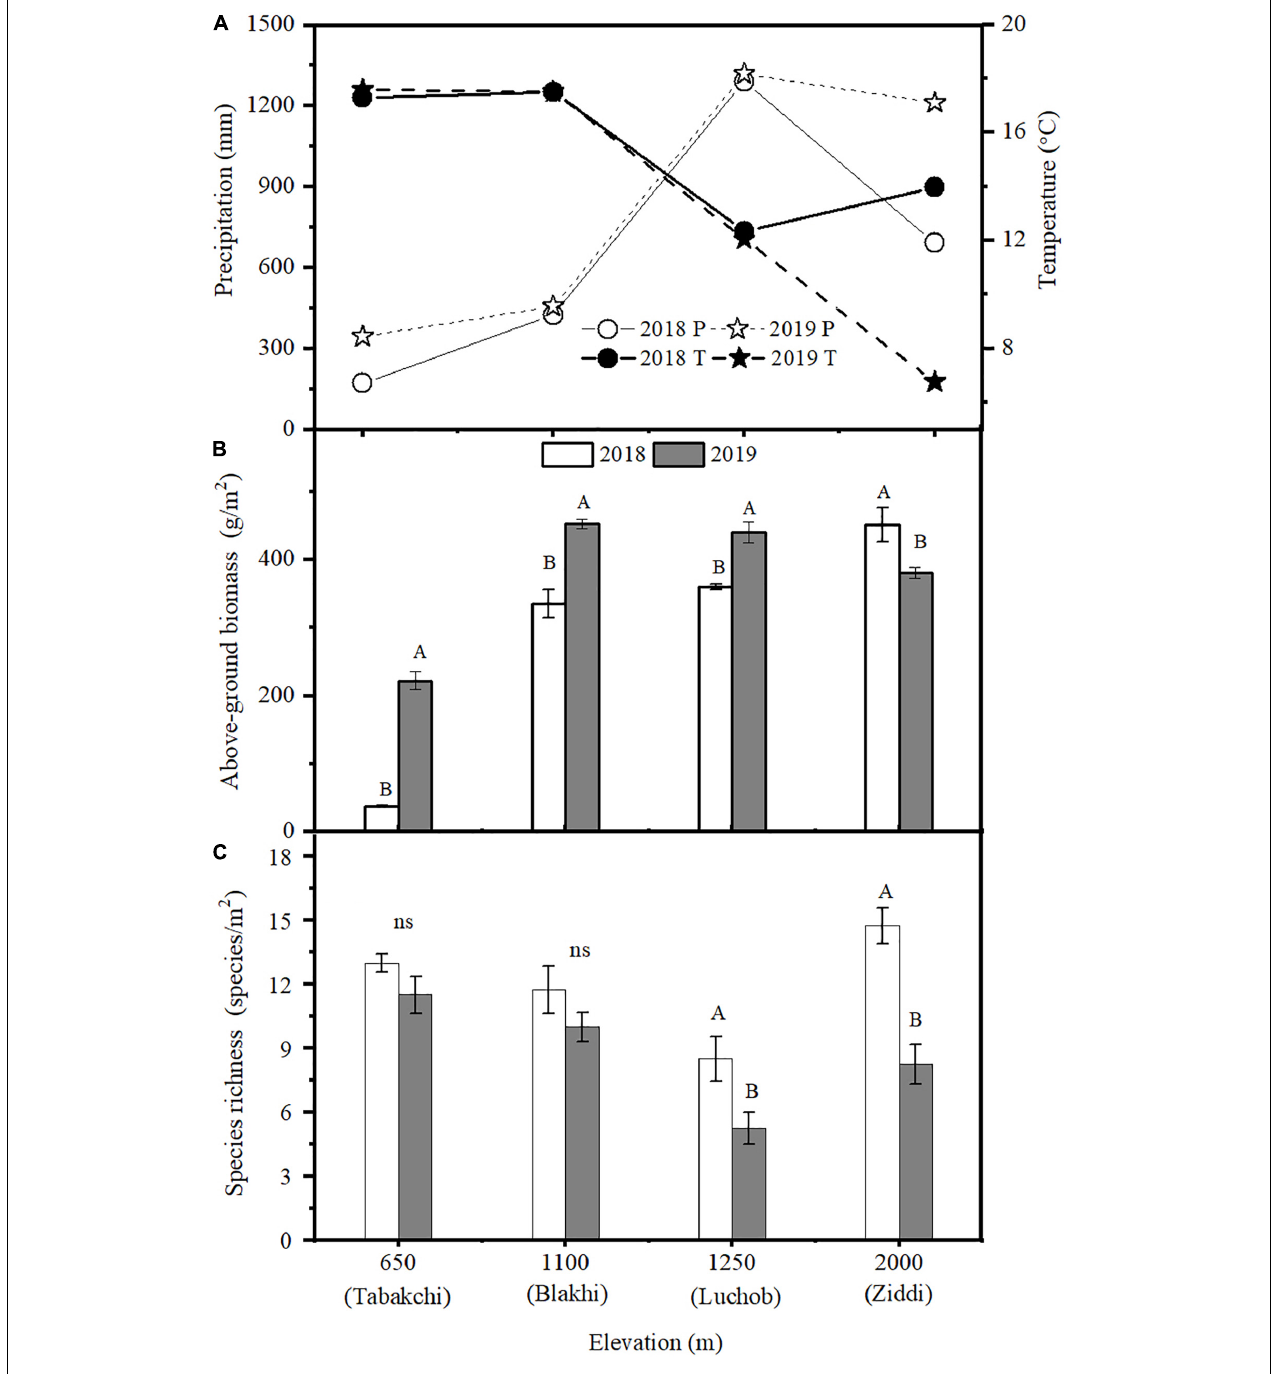
FIGURE 5 | Annual total precipitation and annual average temperature at different elevations (A) , the average above-ground biomass (B) , and species richness (C) in 2018 and 2019. Data of the control treatment were used (mean ± SE). Different capital letters indicate significant difference between years at the same elevation ( p < 0.05), ns, no significant